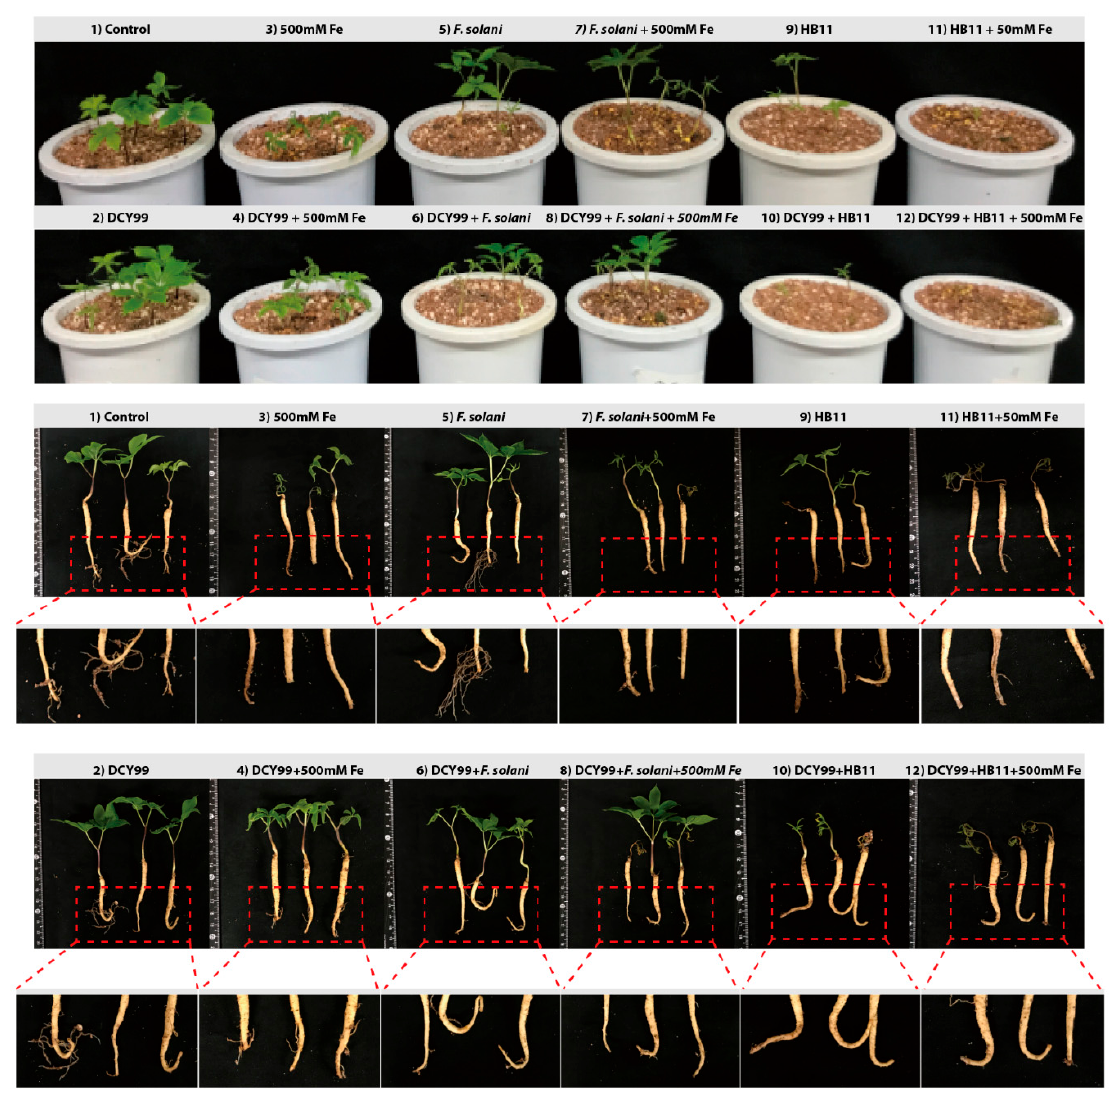
Figure 4. Pot assessment of iron tolerance in P. ginseng and resistance against the fungal infection. Morphological appearance of P. ginseng in response to iron stress and fungal infection. Pot assay was observed by morphological alterations after 7 days of bacterial inoculation, each pot included five seedlings. (1) Control; (2) P. ginseng seedlings inoculated with S. panacis DCY99 T ; (3) Control under 500 mM iron stress; (4) P. ginseng seedlings inoculated with S. panacis DCY99 T under 500 mM iron stress; (5) P. ginseng seedlings inoculated with F. solani ; (6) P. ginseng seedlings inoculated with F. solani and S. panacis DCY99 T ; (7) P. ginseng seedlings inoculated with F. solani under 500 mM iron stress; (8) P. ginseng seedlings inoculated with F. solani and S. panacis DCY99 T under 500 mM iron stress; (9) P. ginseng seedlings inoculated with I. mors-panacis HB11; (10) P. ginseng seedlings inoculated with I. mors-panacis HB11 and S. panacis DCY99 T ; (11) P. ginseng seedlings inoculated with I. mors-panacis HB11 under 500 mM iron stress; (12) P. ginseng seedlings inoculated with I. mors-panacis HB11 and S. panacis DCY99 T under 500 mM iron stress. During iron exposure, the aerial parts and roots of ginseng plants were visibly stressed, however, when the seedlings were primed with S . panacis DCY99 T at the time of iron exposure, iron tolerance was exhibited. But, S. panacis DCY99 T did not fully confer antifungal effect to seedlings.